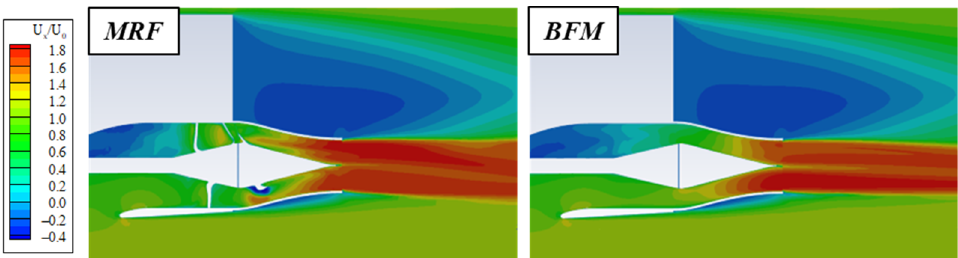
Figure 18. Non-dimensional axial velocity at longitudinal section inside the waterjet with the MRF model and body-force model (BFM).